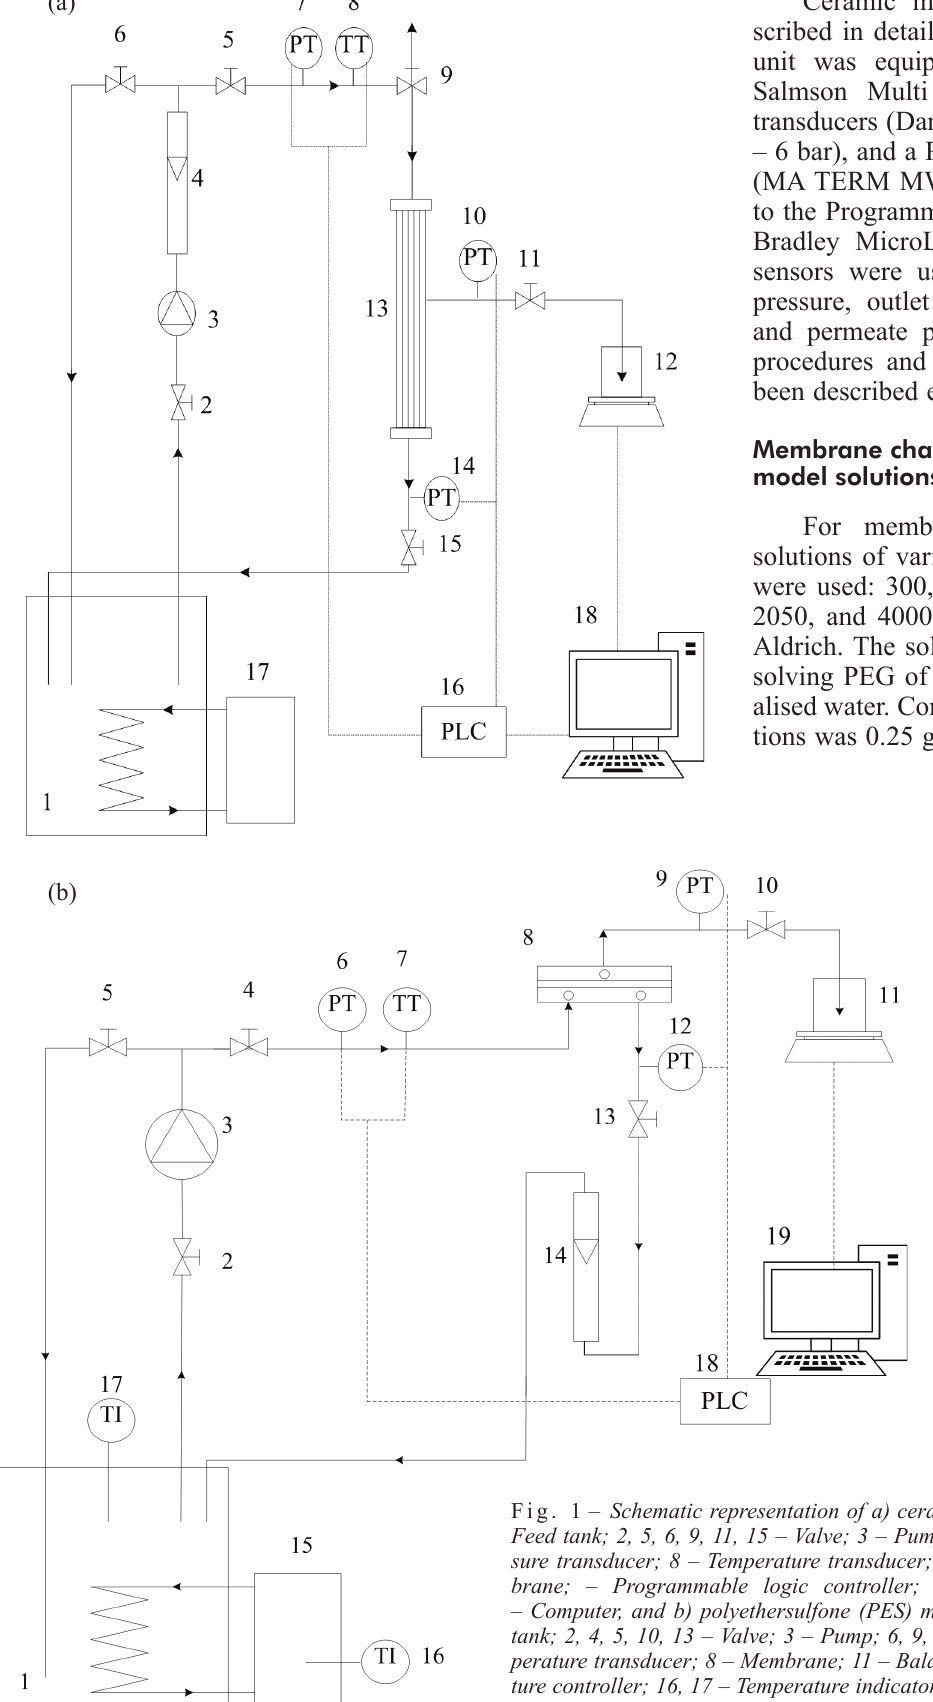
Fig. 1 – Schematic representation of a) ceramic membrane separation unit (1 – Feed tank; 2, 5, 6, 9, 11, 15 – Valve; 3 – Pump; 4 – Rotametar; 7, 10, 14 – Pres­ sure transducer; 8 – Temperature transducer; 12 – Balance; 13 – Ceramic mem­ brane; – Programmable logic controller; 17 – Temperature controller; 18 – Computer, and b) polyethersulfone (PES) membrane separation unit (1 – Feed tank; 2, 4, 5, 10, 13 – Valve; 3 – Pump; 6, 9, 12 – Pressure transducer; 7 – Tem­ perature transducer; 8 – Membrane; 11 – Balance; 14 – Rotameter; 15– Tempera­ ture controller; 16, 17 – Temperature indicator; 18 – Programmable logic control­ ler; 19 –